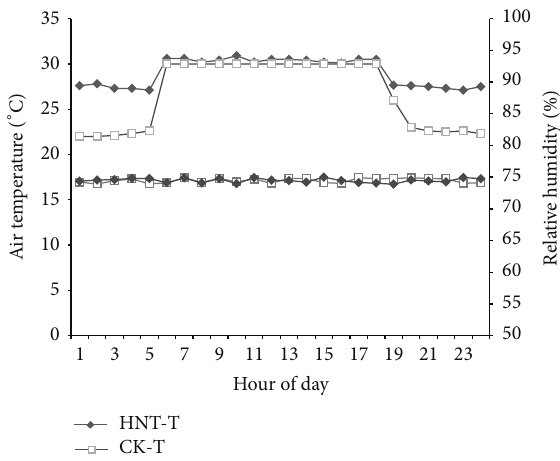
Figure 1: Changes in the air temperature and relative humidity over a day. Plants were grown under two different night temperatures (22 and 27 ∘ C) and the same day temperature (30 ∘